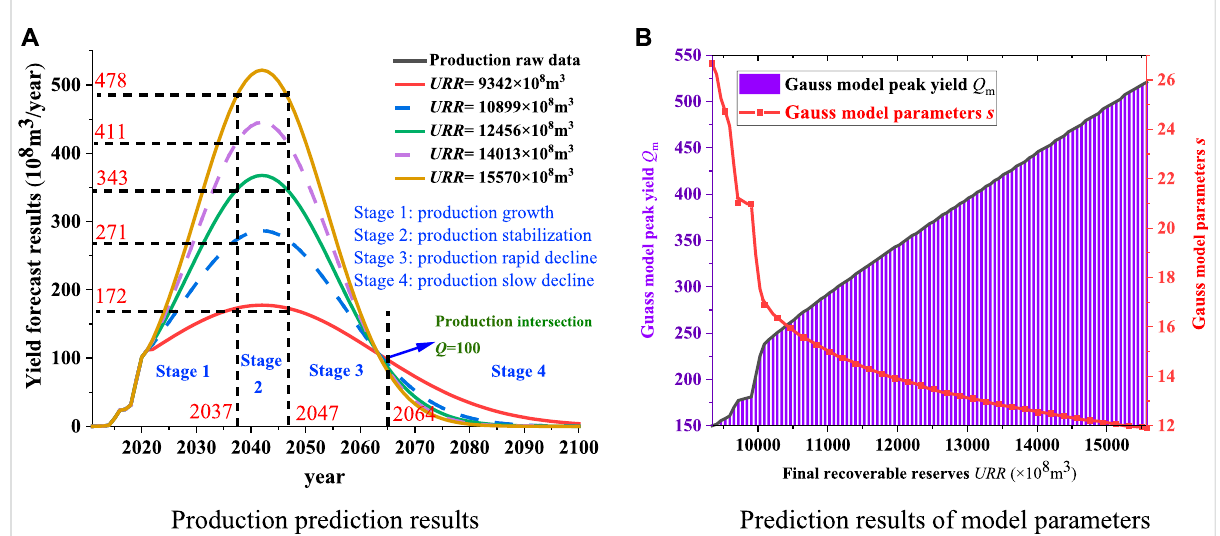
FIGURE 7 Prediction results of natural gas production based on Gauss model. (A) Production prediction results. (B) Prediction results of model